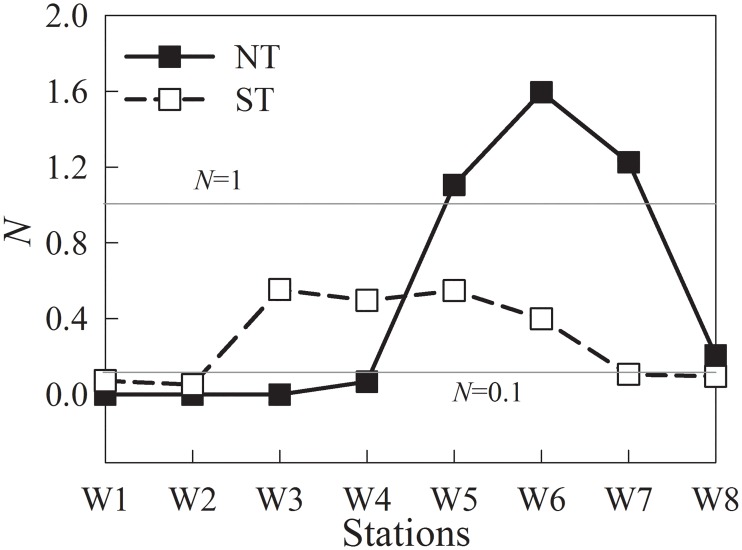
Stratification indexes (N) of the transect during NT and ST.